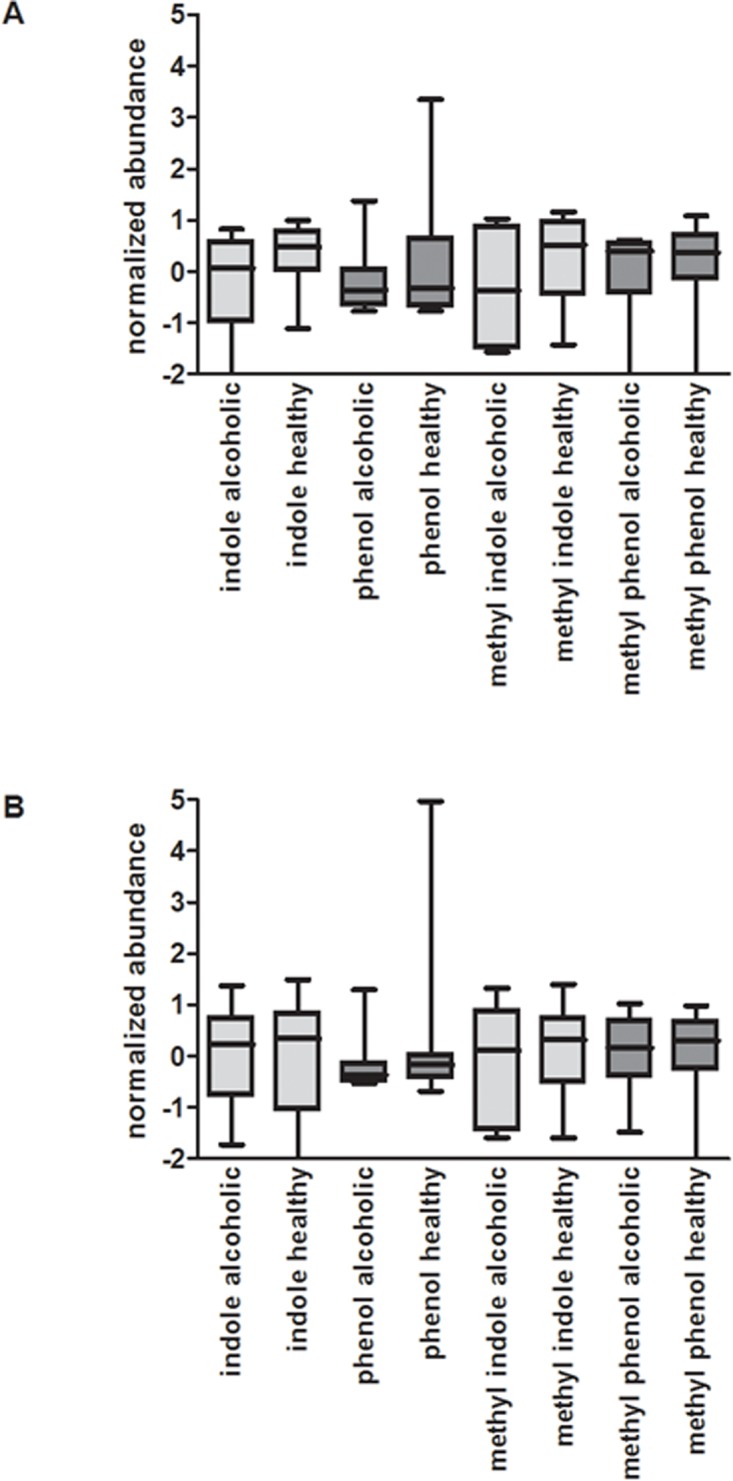
Comparison of protein putrefaction products among the cohorts.Box plots depicting relative metabolite abundance are shown, as described in Fig. 8. A) Among the endoscopy collected samples, with the exception of methyl indole, the metabolites are comparable in abundance within the healthy and alcoholic cohorts. Note however, the difference observed with methyl indole is not statistically significant (p = 0.519). B) In the home collected samples, metabolite abundance is very similar between the healthy and alcoholic fecal samples.